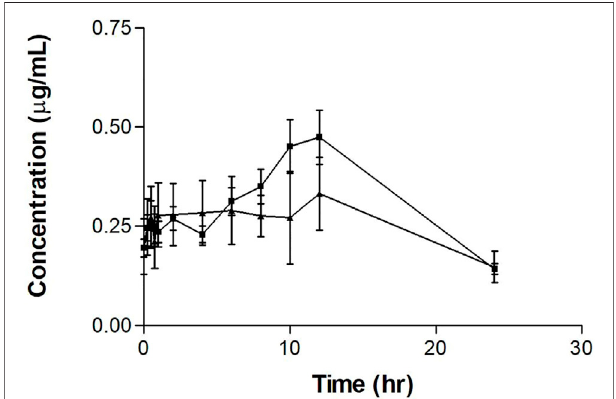
FIGURE 2 | Mean serum concentration-time pro fi les of tamoxifen after repeated oral tamoxifen dosing (20 mg/kg for 12 days) ( ▲ ) with or without PSP extract (340 mg/kg orally on days 5 – 11) ( ■ ) in female Sprague-Dawley rats. Each point represents as the mean ± SEM ( n = 5).